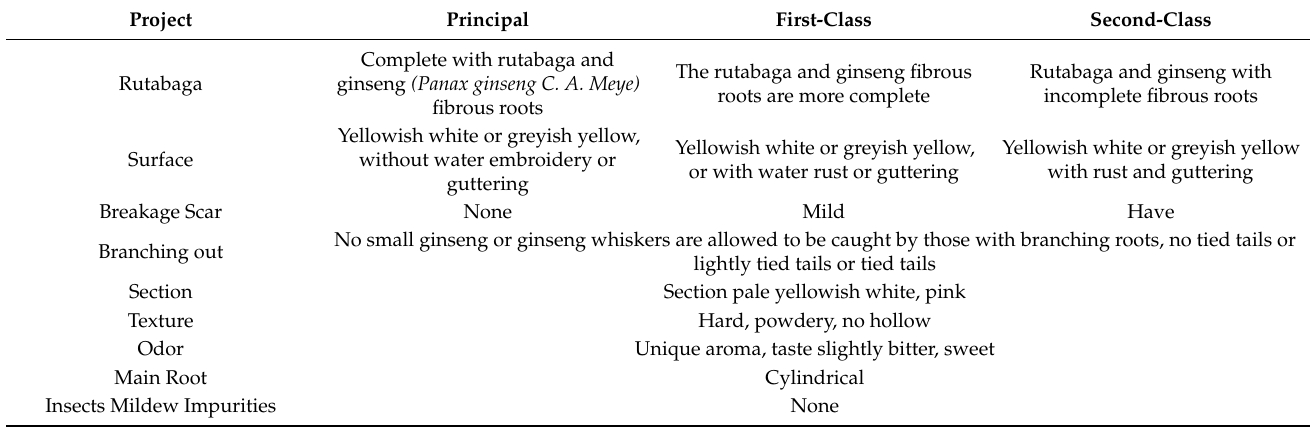
Table 1. Scoring criteria.